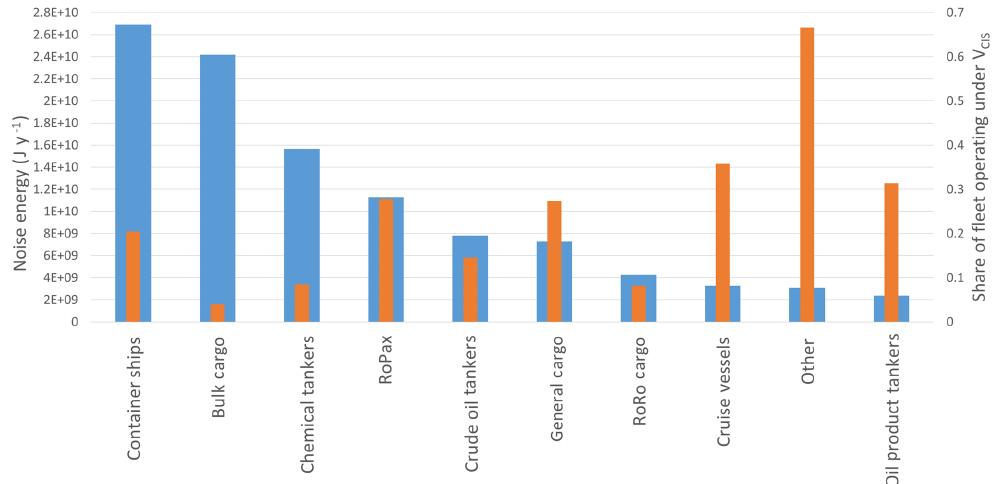
Figure 5. Noise energy emitted by different ship types in 125Hz frequency band (in joules per year; blue bars, left axis). The share of the fleet operating under their cavitation inception speed is also indicated (orange bars, right axis). For example, container ships are the biggest source of noise energy in the Baltic Sea fleet with 27GJ, of sound power emitted. Of the container ship fleet, about 20% operate at speeds lower than their predicted cavitation inception